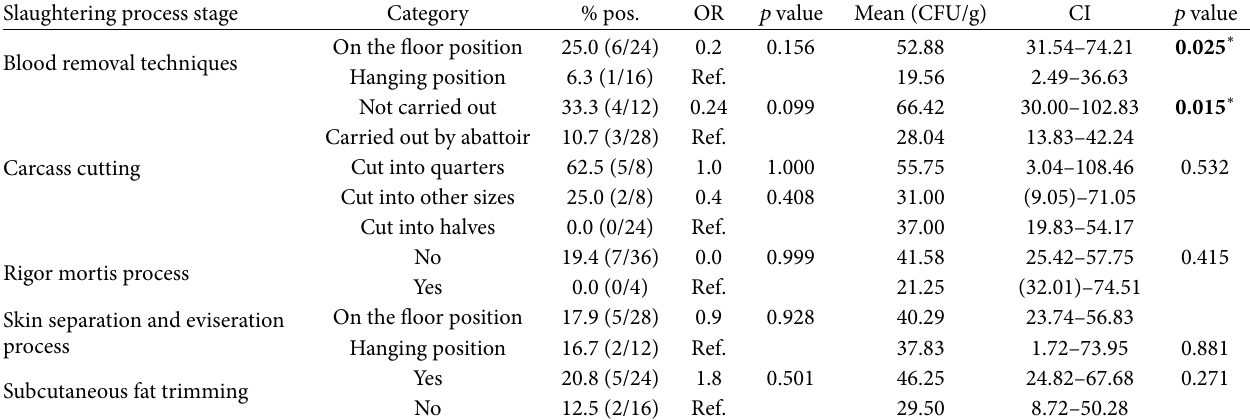
Table 4: Staphylococcus aureus